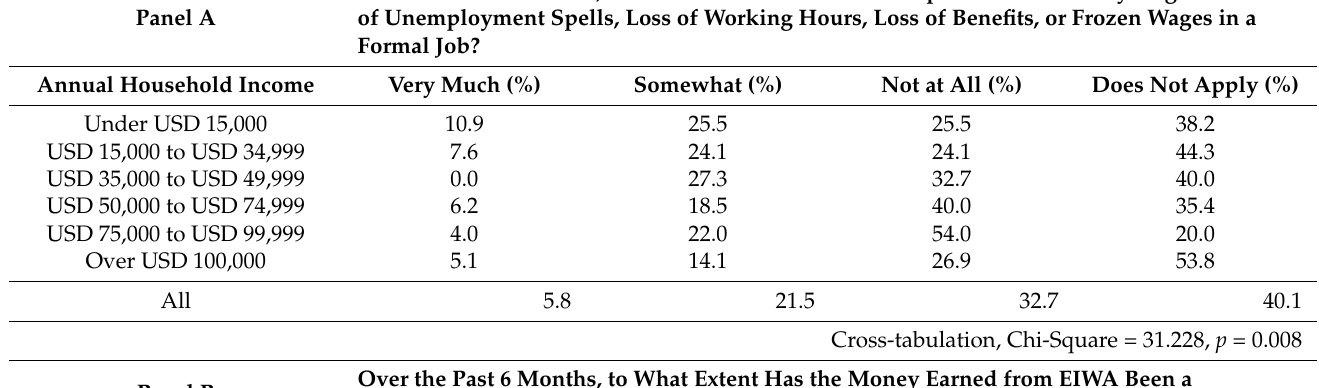
Cross-tabulation, Chi-Square = 31.228, p = 0.008